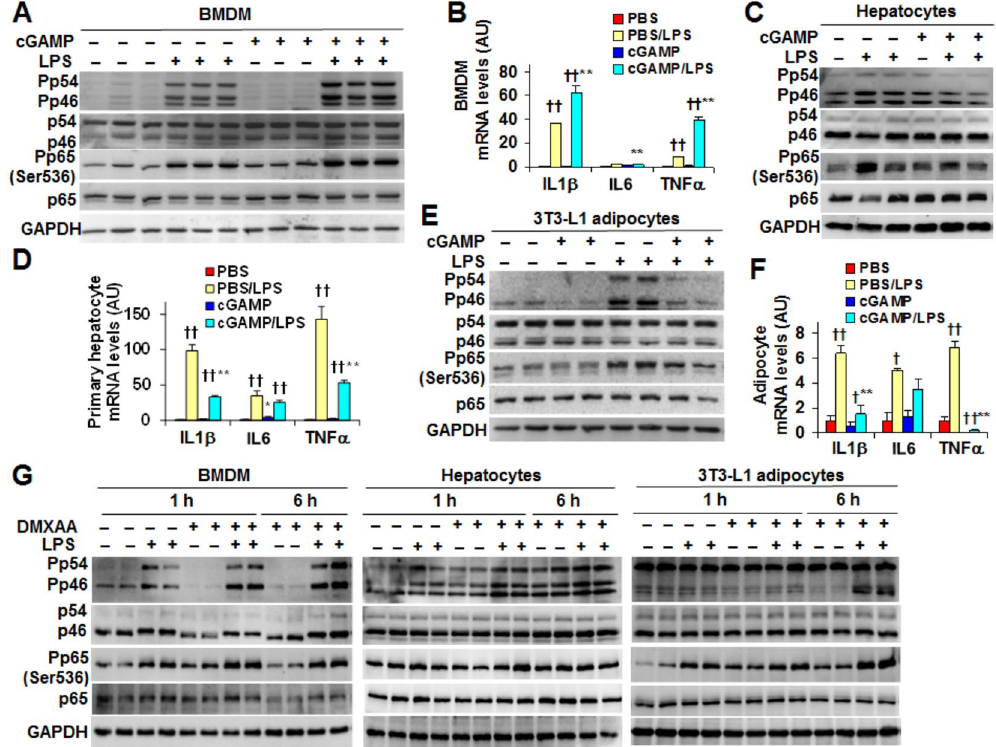
Figure 5. Exogenous cGAMP exerts cell-type-specific anti-inflammatory effects distinctly from STING activation. ( A , B ) Proinflammatory signaling (A) and cytokine expression (B) in bone marrow-derived macrophages (BMDM). ( C , D ) Proinflammatory signaling (C) and cytokine expression (D) in primary mouse hepatocytes. ( E , F ) Proinflammatory signaling (E) and cytokine expression (F) in differentiated 3T3- L1 adipocytes. ( G ) DMXAA, an STING activator, enhances the proinflammatory signaling of macrophages, hepatocytes, and adipocytes. For A–G, bone marrow cells and primary hepatocytes were isolated from male C57BL/6 J mice. Also, bone marrow cells were differentiated into macrophages and 3T3-L1 cells were differentiated into adipocytes prior to cGAMP treatment. For A–F, cells were treated with enzymatically synthesized cGAMP (20 µ g/ml in A, B, E, and F), commercial chemically synthesized cGAMP (20 µ g/ml in C and D), or PBS for 24 hr in the presence or absence of LPS (100 ng/ml for the last 30 min in A, C, and E; 20 ng/ml for the last 6 hr in B, D, and F). For G, cells were treated with DMXAA (75 µ g/ml, 100 × stock in 7.5% NaHCO 3 ) or NaHCO 3 solution (Ctrl) for 1 or 6 hr in the presence or absence of LPS (100 ng/ml) for the last 30 min. For bar graphs, data are means ± S.E. n = 6–8. * , P < 0.05 and ** P < 0.01 cGAMP vs. PBS or cGAMP/ LPS vs. PBS/LPS for the same gene; †† P < 0.01 PBS/LPS vs. PBS or cGAMP/LPS vs. cGAMP for the same gene. For A, C, E, and G, cropped blots were displayed. Also, full-length blots were included in Supplemental Information (Figures